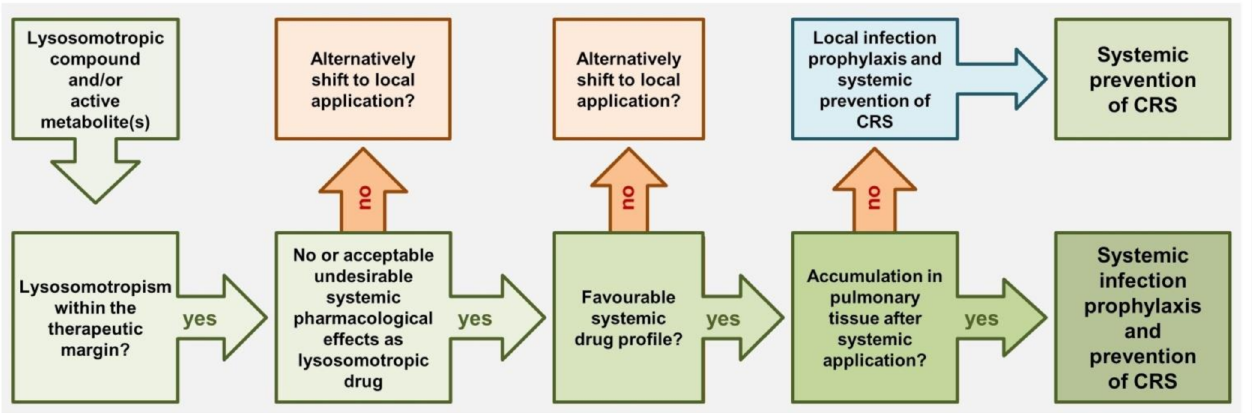
Figure 3. Flowchart for choosing suitable lysosomotropic drugs for (systemic) infection prophylaxis and prevention of transition to COVID-19 according to Table 1. Candidates (active compounds and/or one or more metabolites) should meet the following criteria: lipophilic, weak protonatable nitrogen bases where lysosomotropism is present within the therapeutic margin, no or acceptable undesirable systemic pharmacological effects as lysosomotropic drug are known, favorable systemic drug profile or local application as expedient, and accumulation in pulmonary tissue after systemic